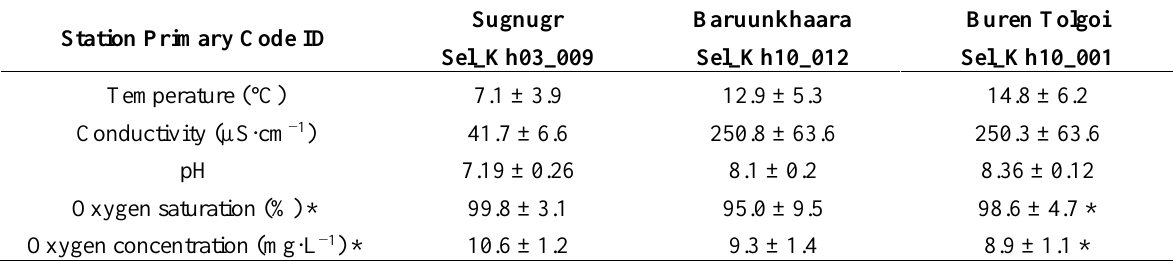
Table 8. Physical and chemical measurements (mean ± SD) of the automatic water quality monitoring stations at Sugnugr (Khentii reference Kh_Trib_2), Baruunkharaa (Middle/Lower Kharaa. Kh_Main_3) and Buren Tolgoi (Lower Kharaa. Kh_Main_4) for the vegetation period (May to October) in 2012. For allocation of primary code ID of stations see Table